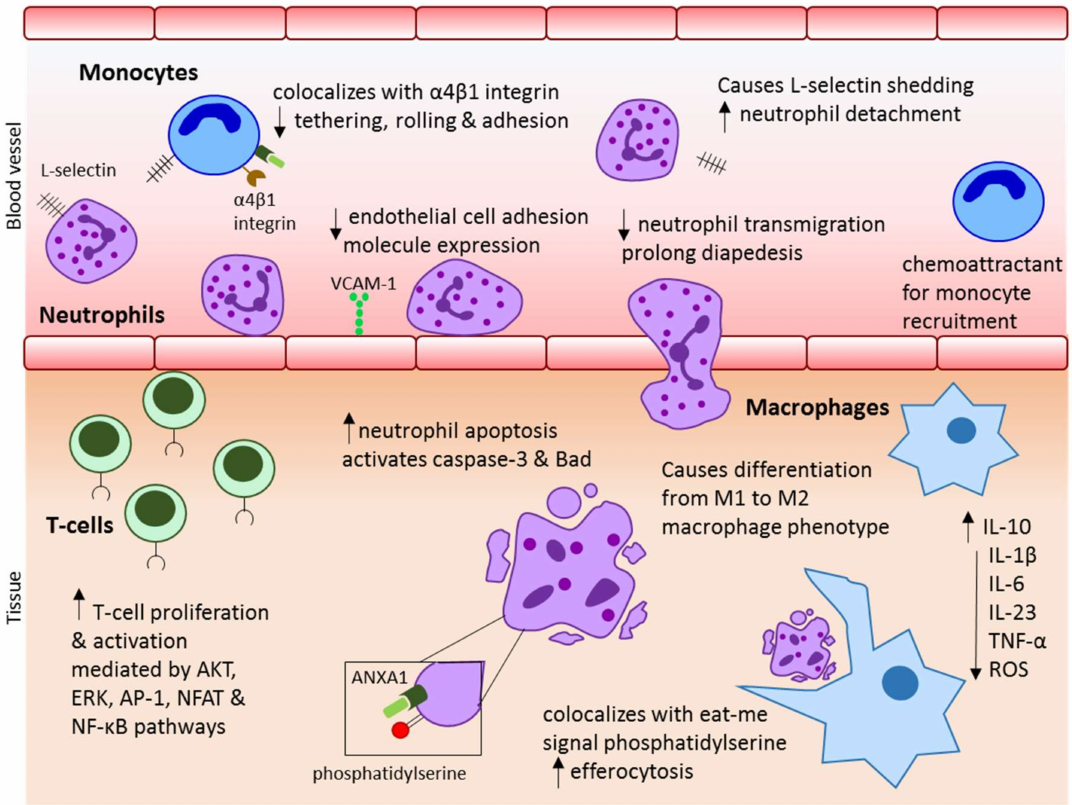
Figure 1. Summary of the role ANXA1 in controlling inflammation through its effect on immune